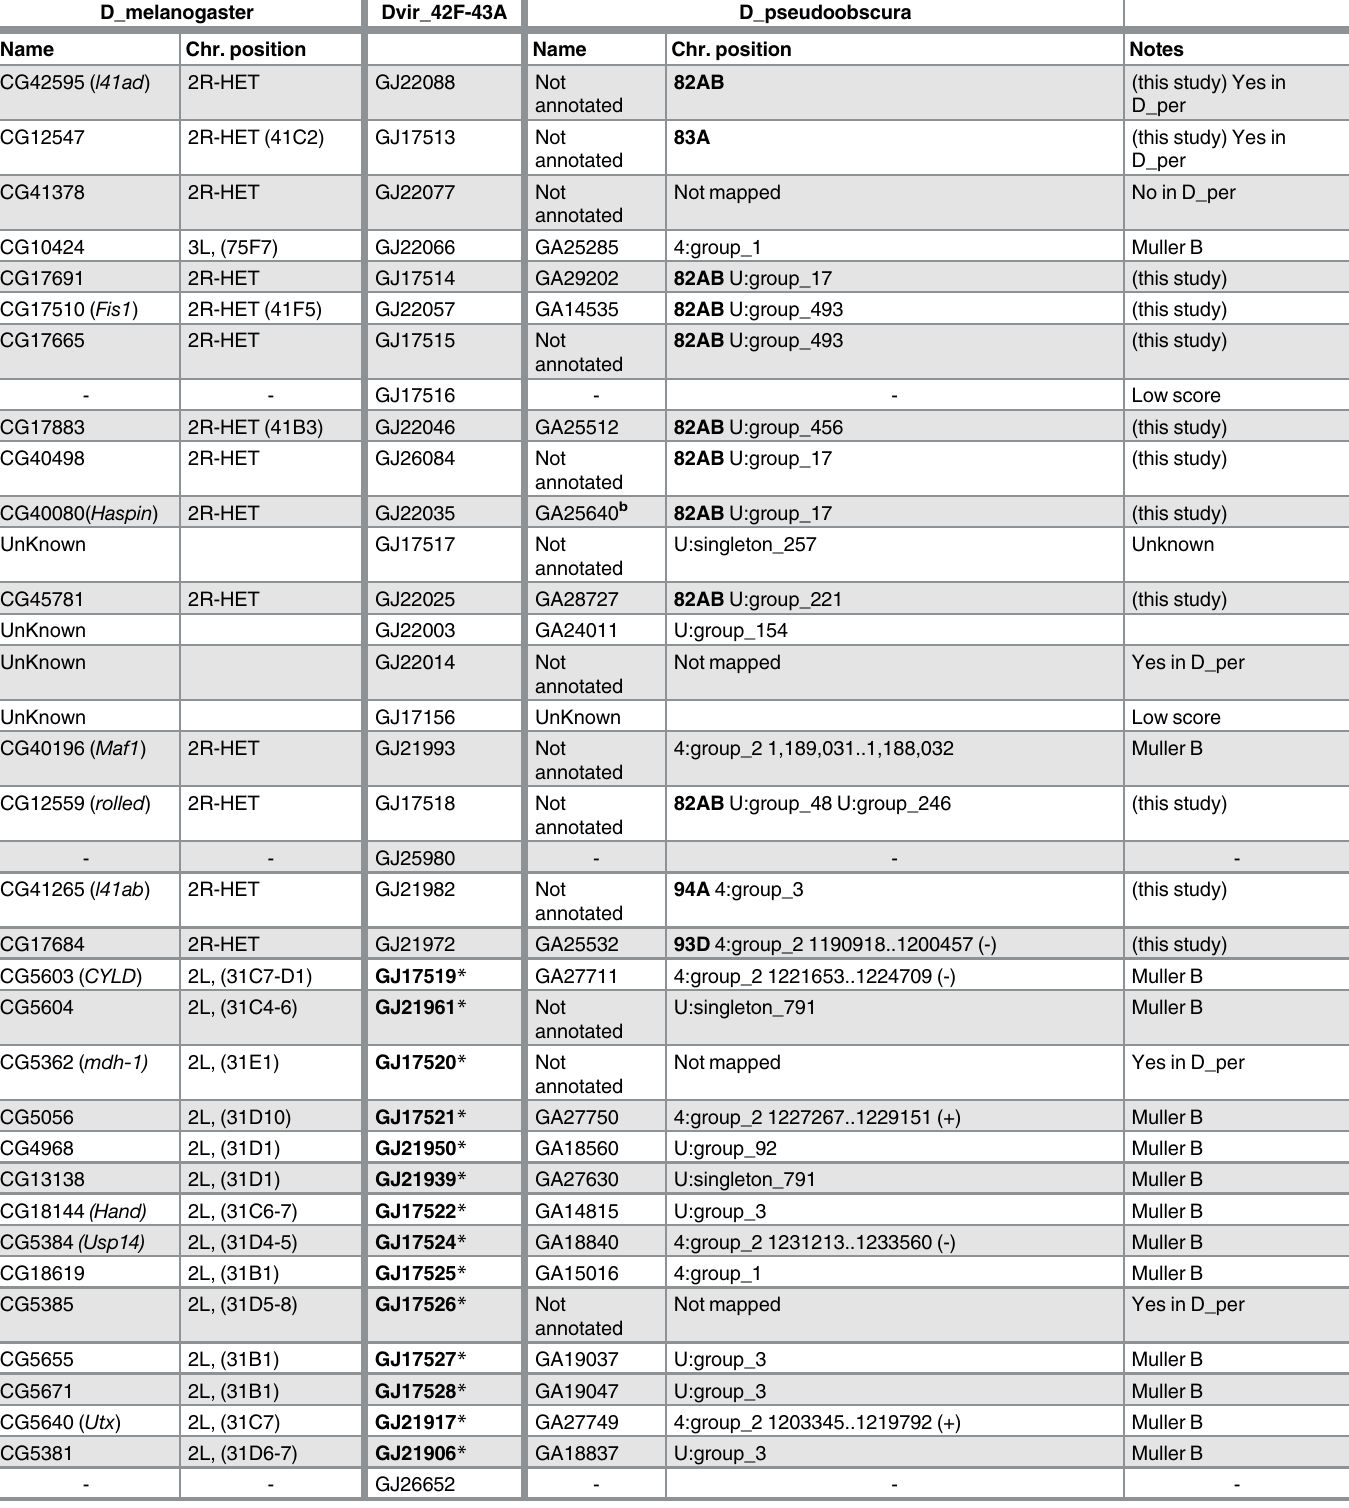
Table 6. List of D . virilis genes at Dvir_42F-43A orthologous to genes of D . melanogaster and D . pseudoobscura .